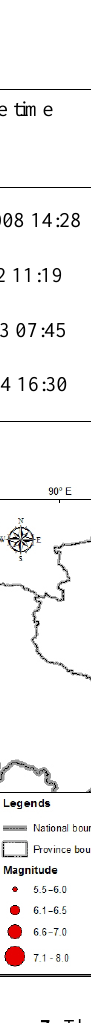
Figure 6. Theoretic isoseismal map of the Minxian earthquake (de- tailed information about the Minxian earthquake is listed in the Ta- ble 4).